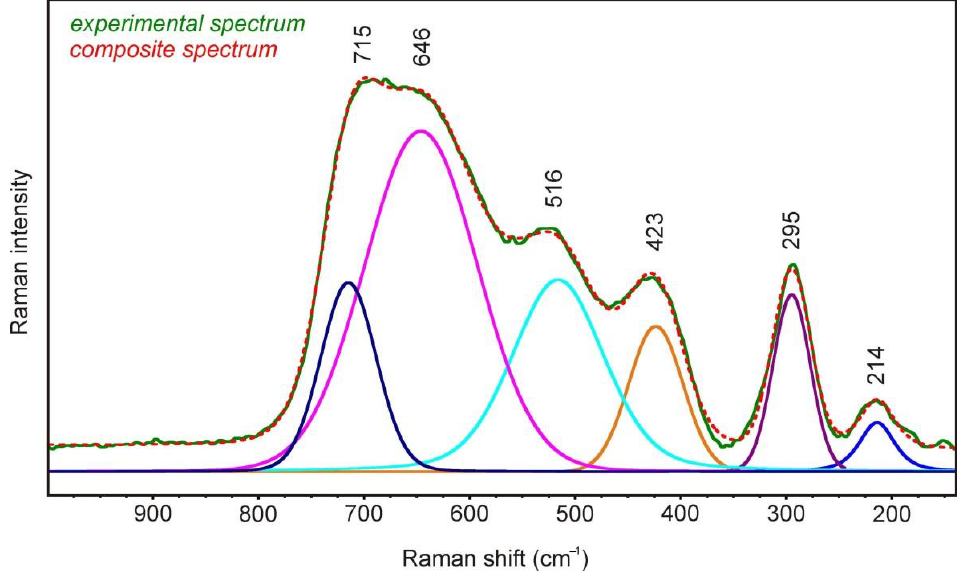
Figure 5. Raman spectrum of amgaite.